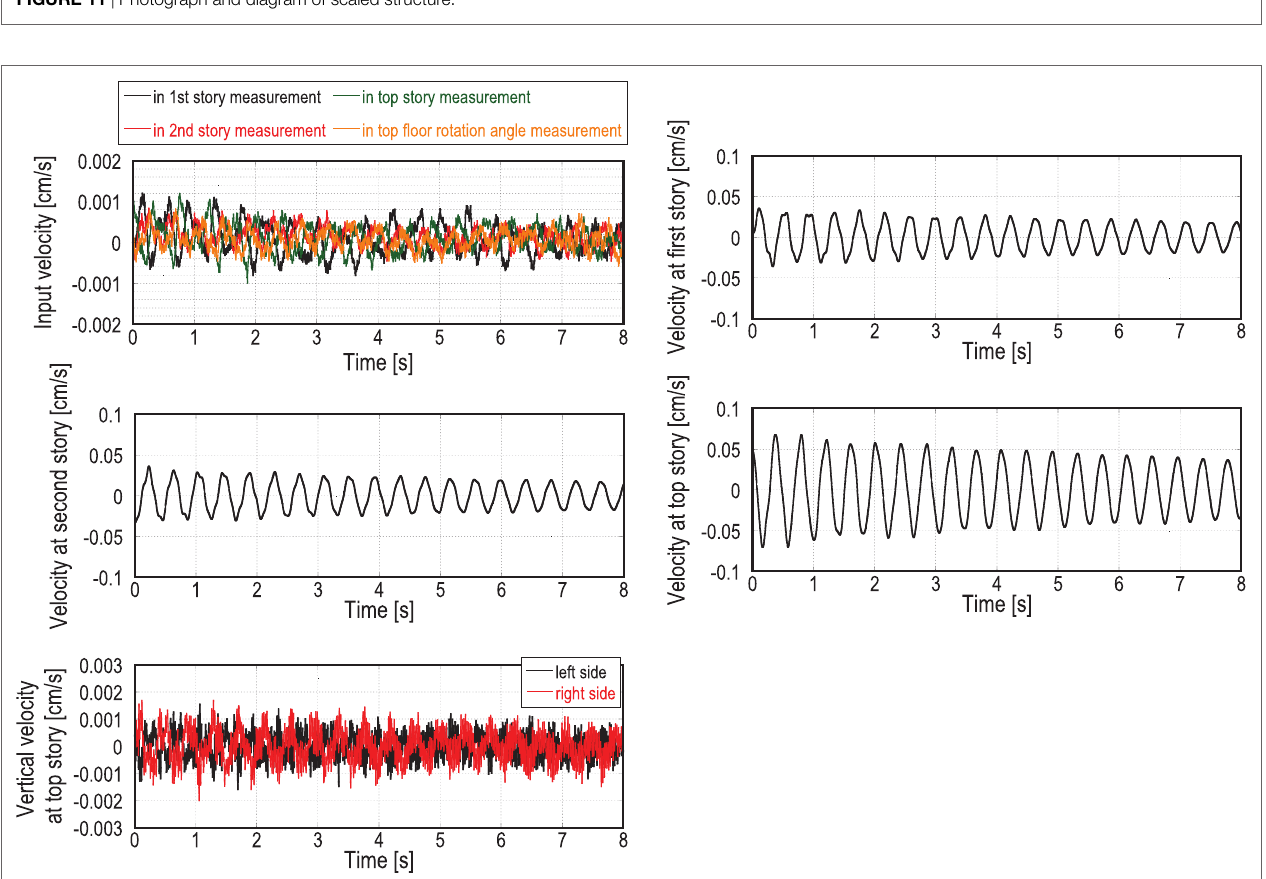
FIGURE 12 | Input and output measured micro-tremor data in non-simultaneous